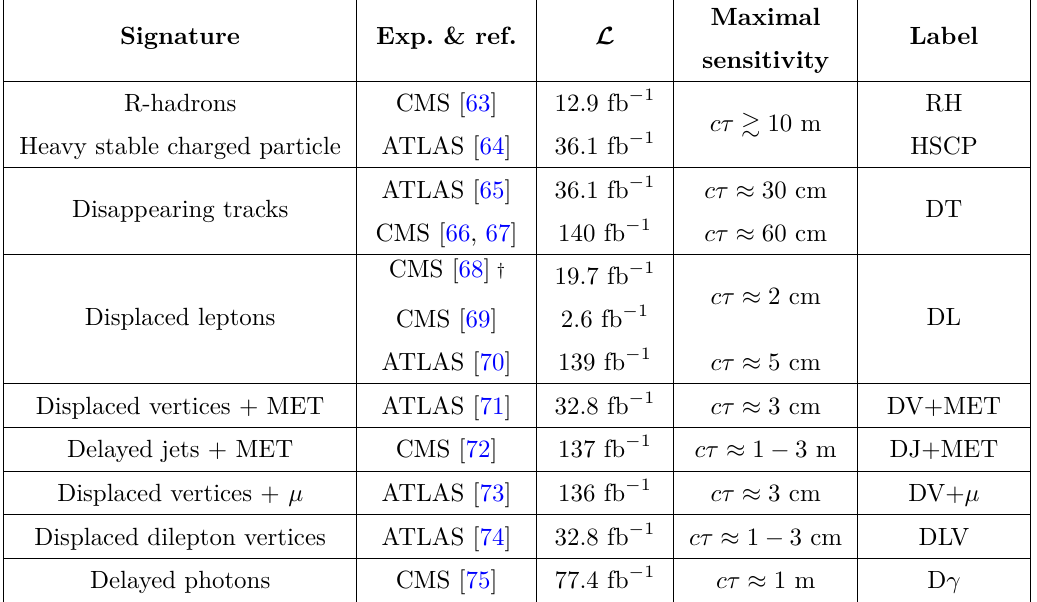
Table 2. Searches for long-lived particles (LLP) at the LHC experiments performed on run data (with the exception of the 8 TeV search denoted by † ). See section 4.1 and appendix C for details. The maximal sensitivities in the proper decay length refer to the models employed in the original refs. of the second column to interpret the